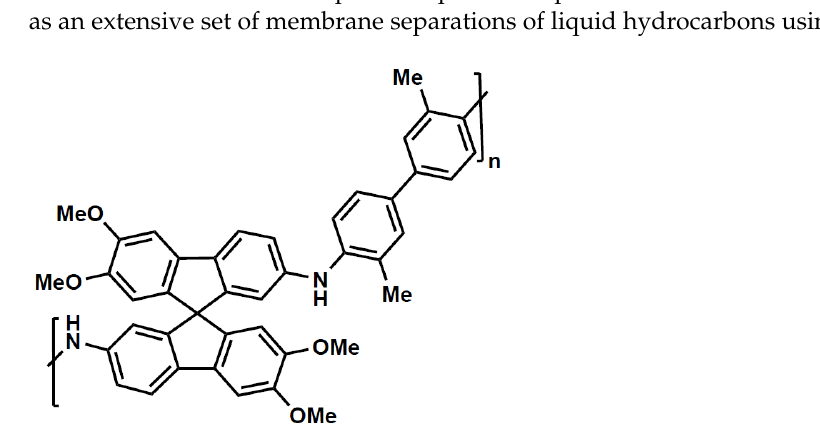
Figure 2. Diagram of SBAD-1 repeat unit [8].